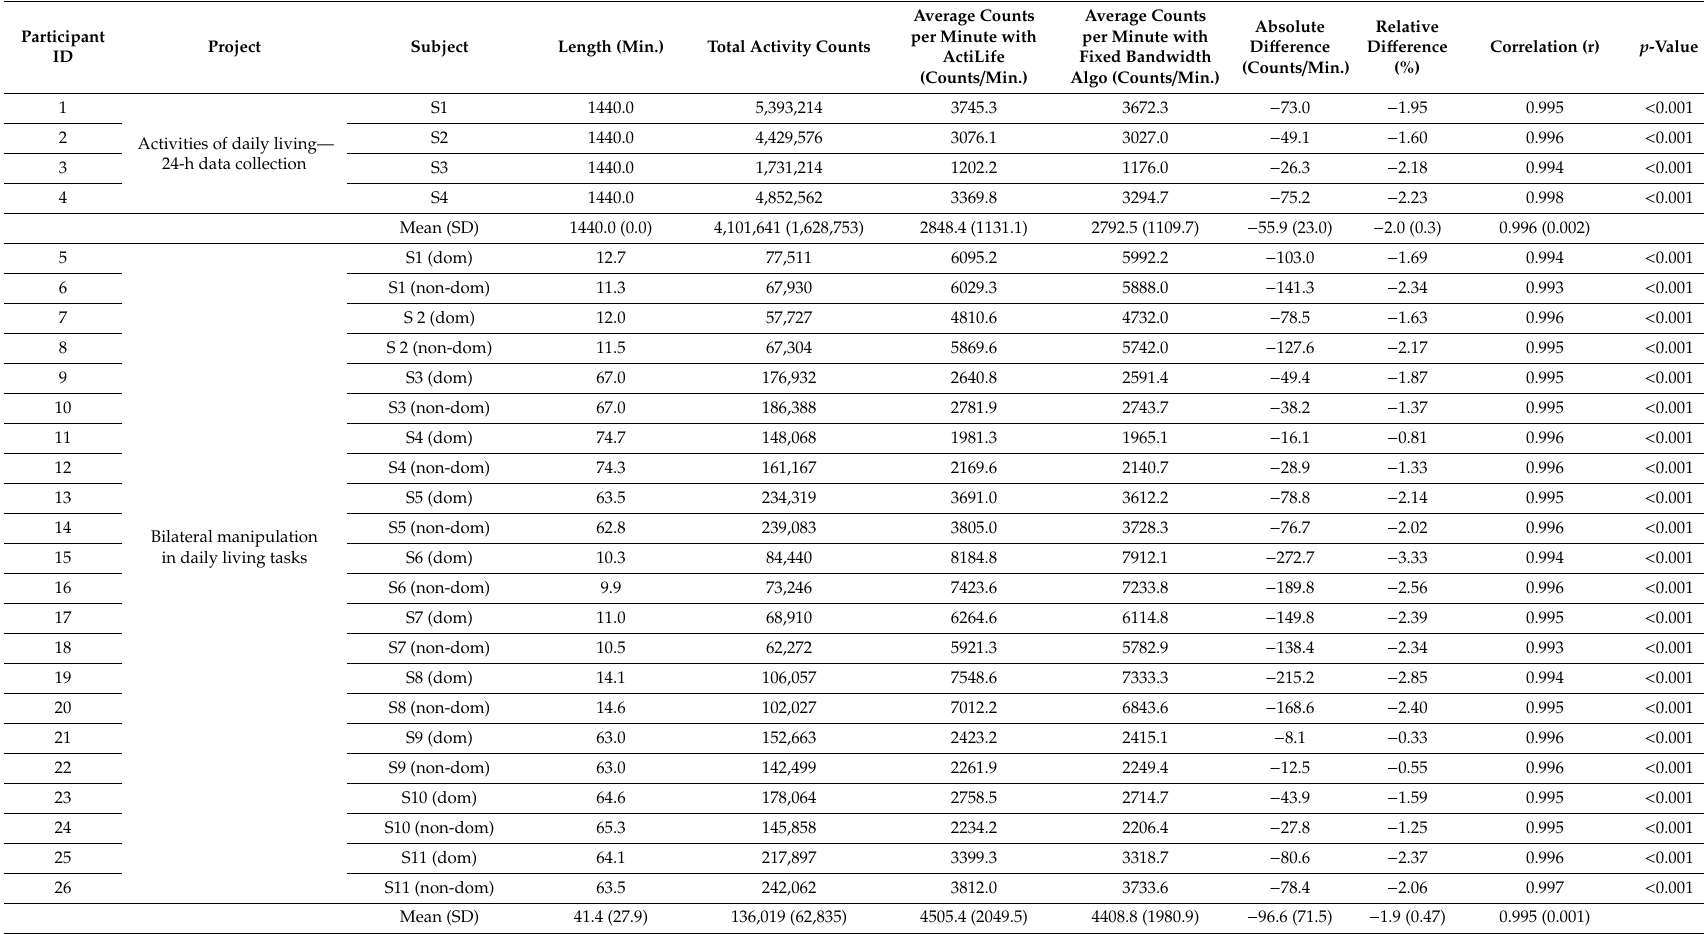
Table 2. Synthesis of data collection characteristics and comparison parameters between the fixed bandwidth algorithm and the commercial solution. “Min.” stands for minute; “dom” stands for dominant; “non-dom” stands for